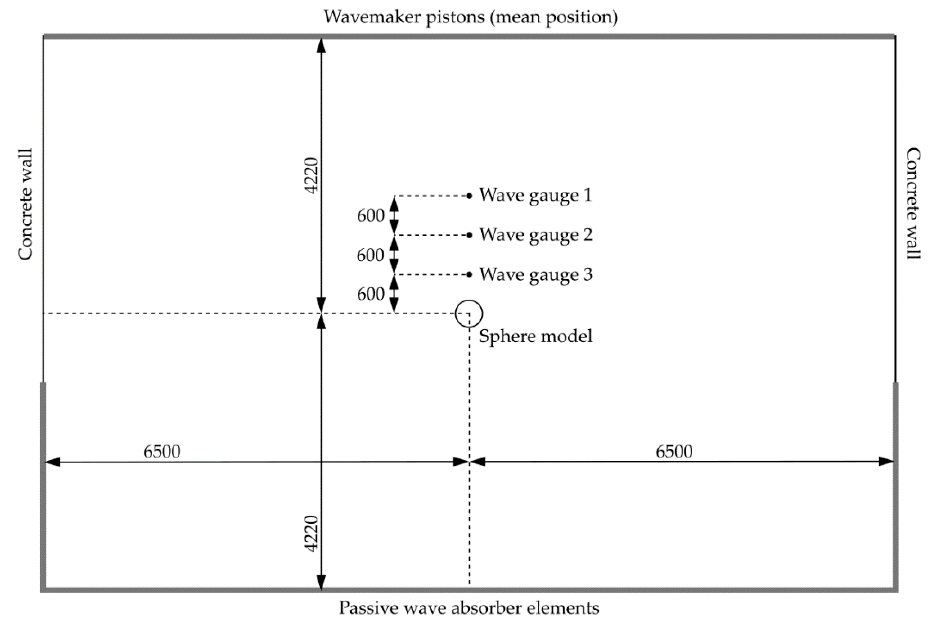
Figure 8. Test setup and measurements of the wave basin. Measurements are given in mm.